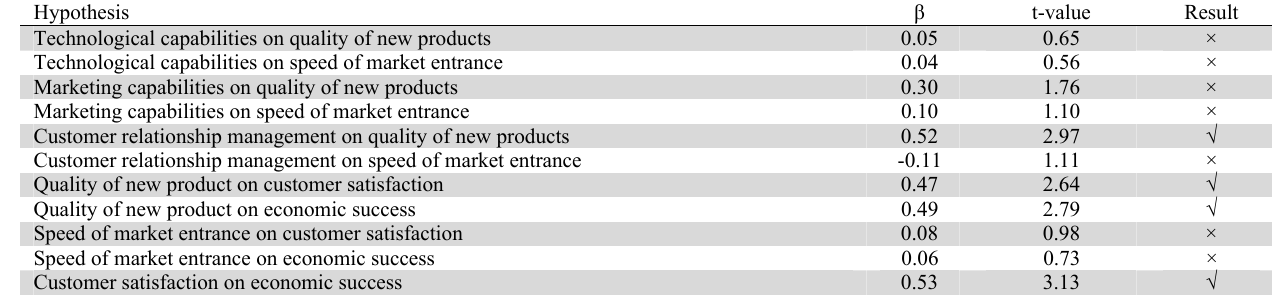
The results of SEM implementation Hypothesis